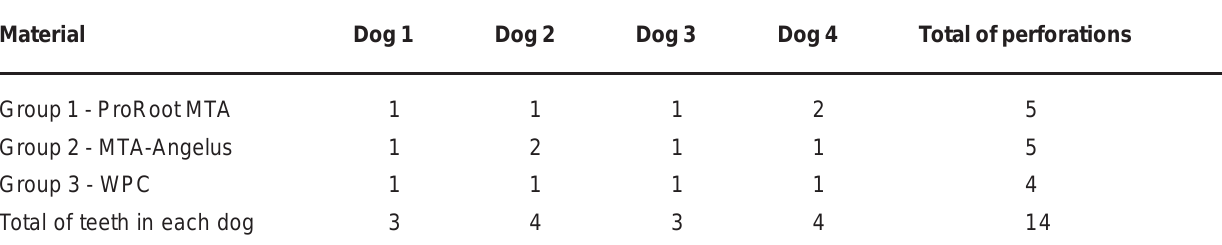
TABLE 2- Distribution of the materials in the four animals prefaced a total of 14 perforations Material